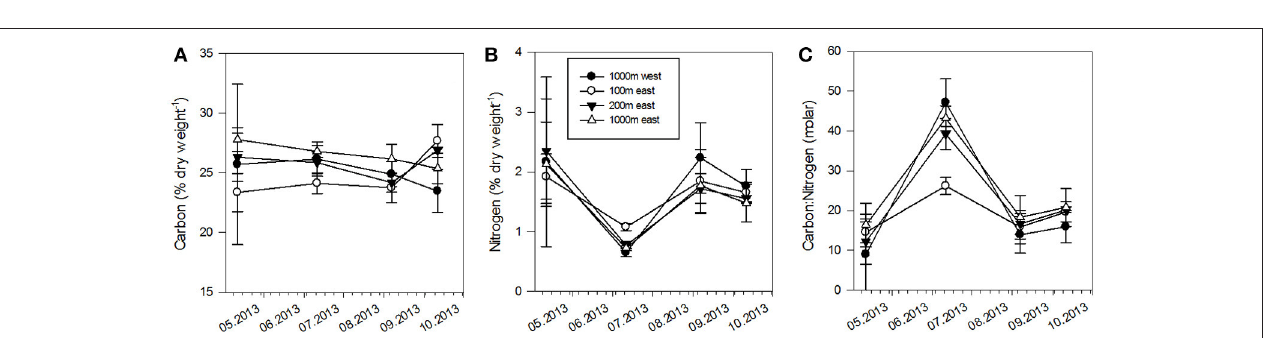
FIGURE 8 | (A) Relative contribution of inorganic nitrogen supplied from either salmon farming or from natural sources in S. latissima based on stable isotope mixing models. Error bars express standard deviation. (B) Relative contribution of inorganic nitrogen supplied from either salmon farming or from natural sources in S. latissima based on stable isotope mixing models as a function of distance from the farm. Model fitted to data is a hyperbolic decay, 2 parameters, R 2 = 0.57.